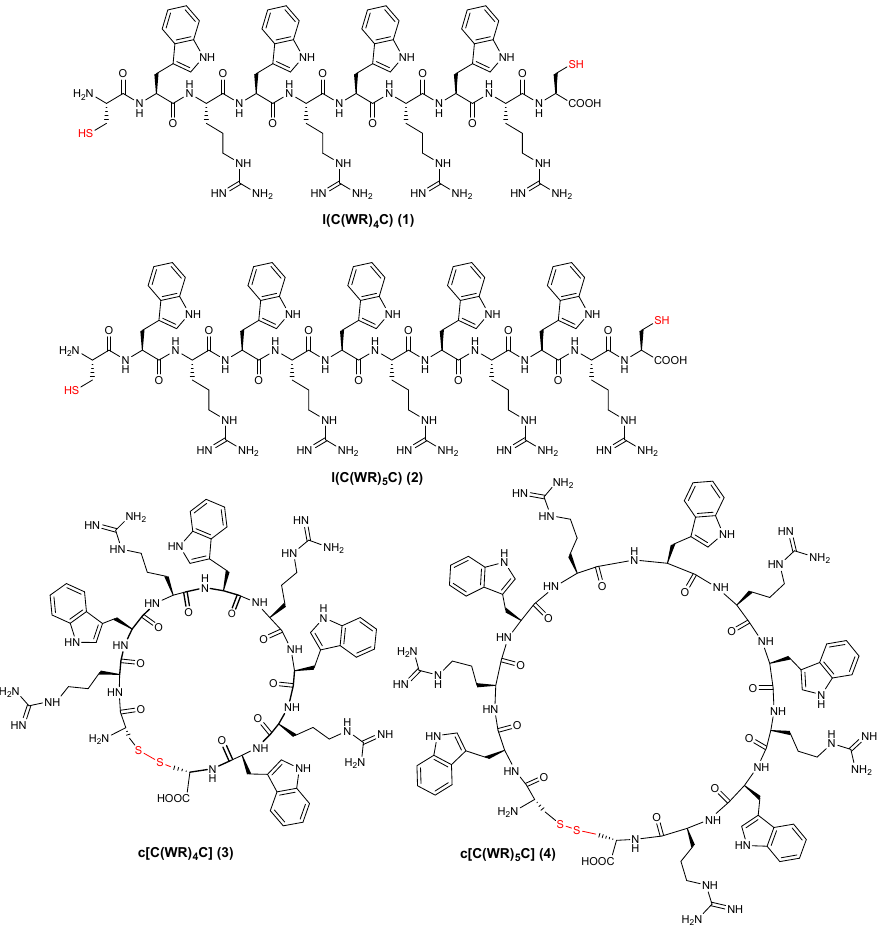
Figure 1. Chemical structures of synthesized peptides.